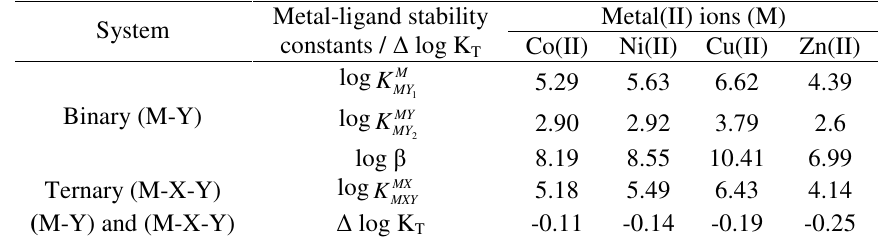
Table 1. Metal-ligand stability constants of binary (M-Y), ternary (M-X-Y) systems and ∆ log K values in 75: 25 (v/v) 1,4-dioxne-water medium at 27±0.5 o C and µ = 0.1 M T